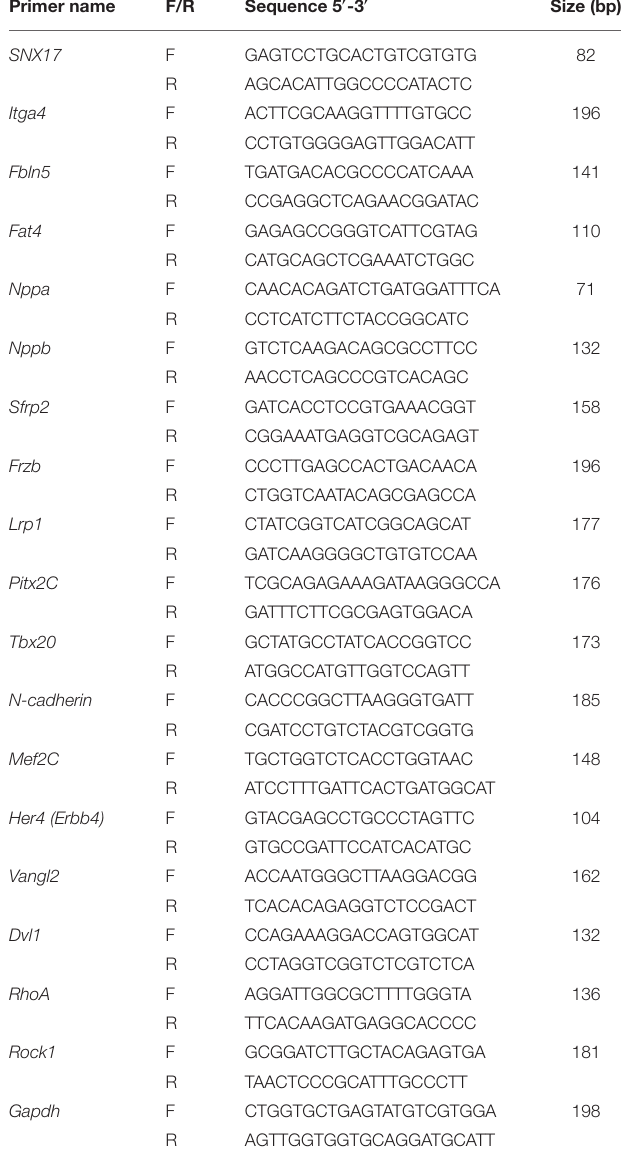
TABLE 3 | List of primers used in